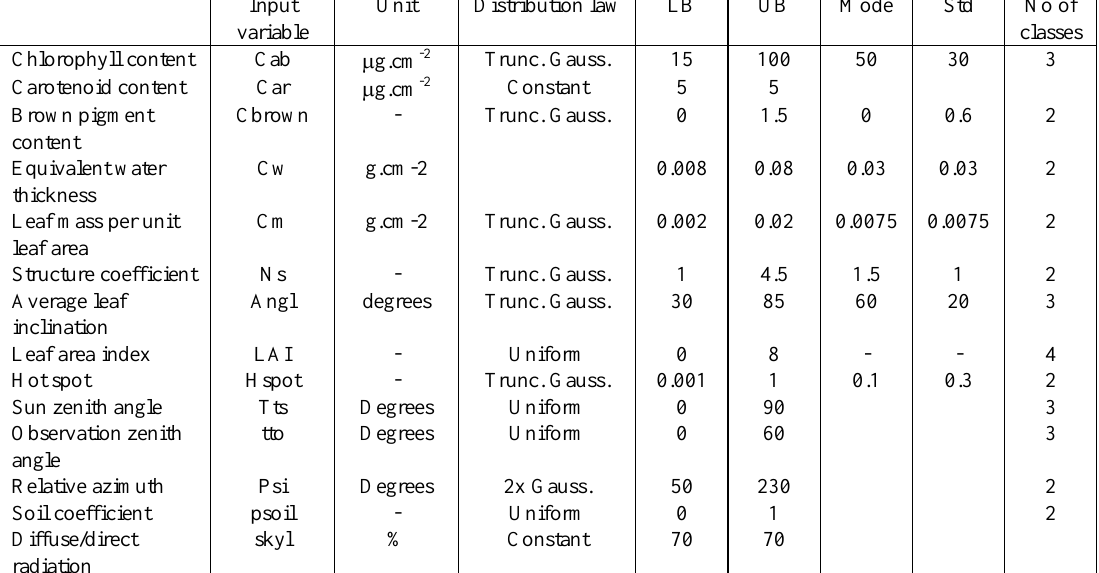
Table 1. Input specifications for PROSAIL